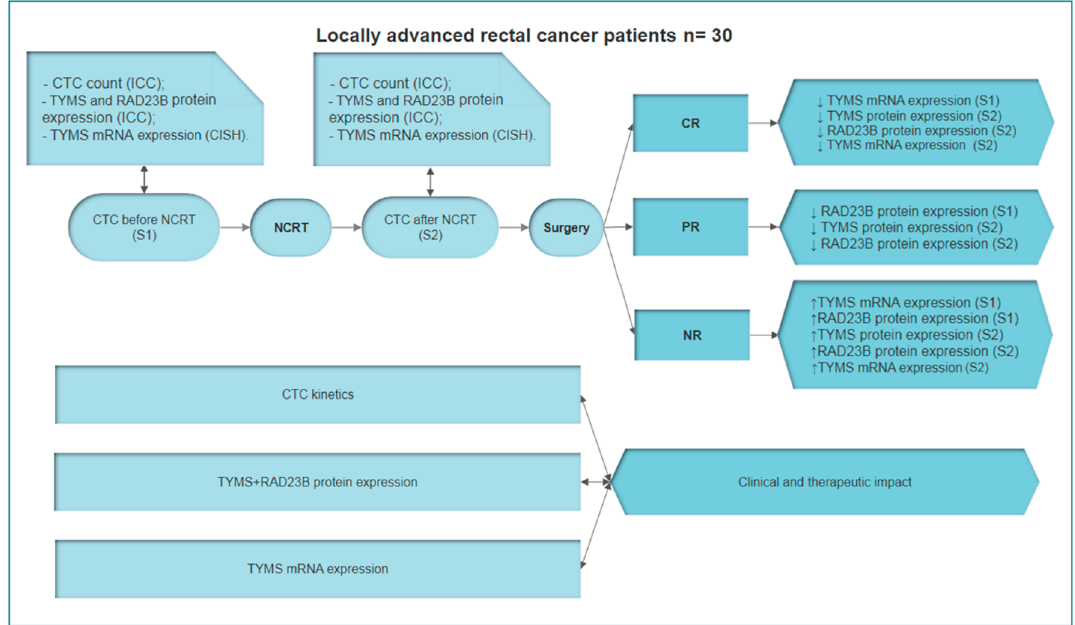
Figure 3. Summary of methodologies, analyses, and results in the present study. Patients were enrolled prior to the start of NCRT. Blood was collected to perform CTC counts and molecular analyses. At baseline, complete response (CR) correlated with low levels of TYMS mRNA. In contrast, NR correlated with high levels of TYMS mRNA and RAD23B protein expression. Blood samples were collected again during follow-up after NCRT. CTC analyses showed that CR correlated to low levels